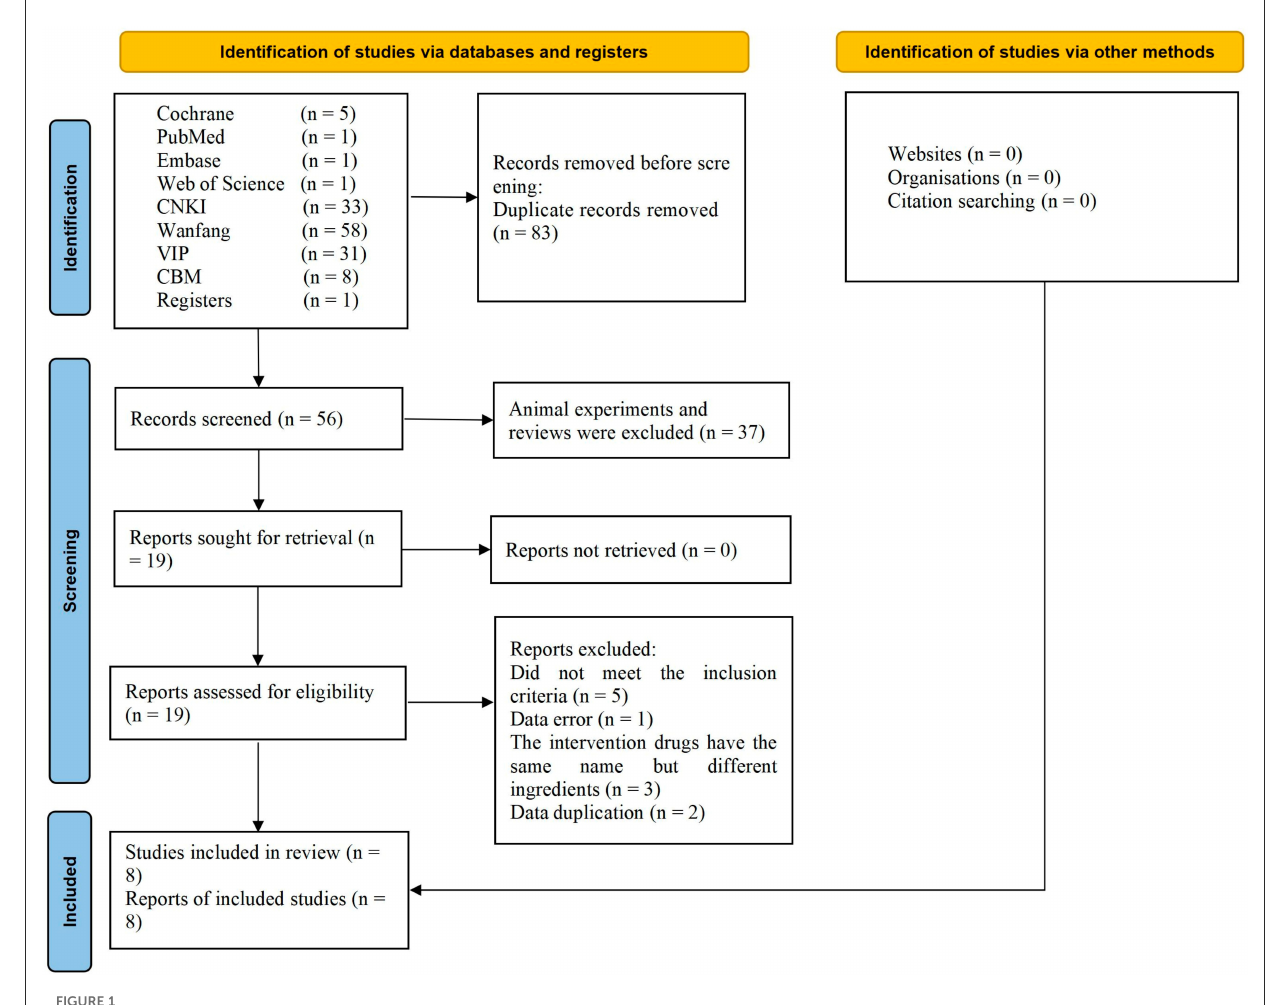
FIGURE1 PRISMA flow diagram indicating the selection process for this